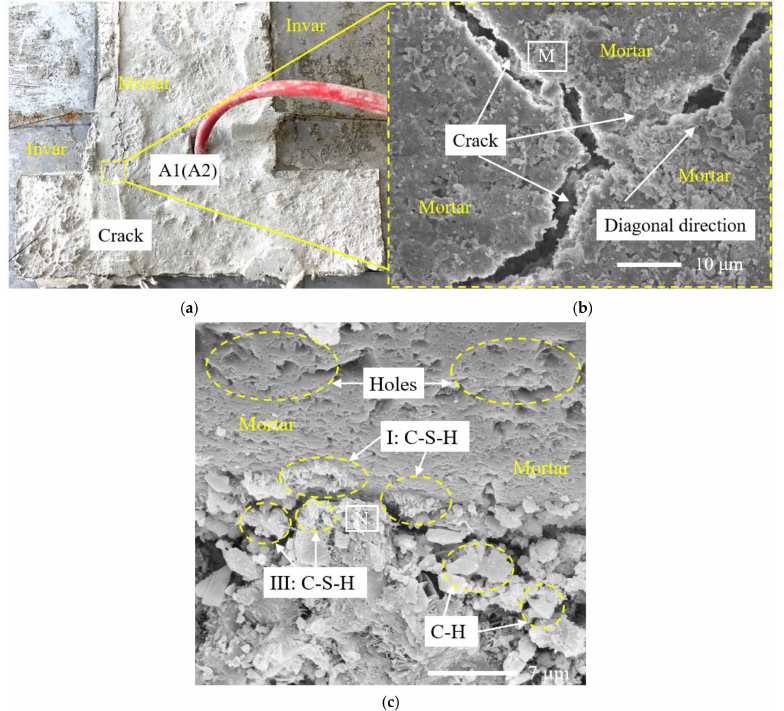
Figure 8. Microstructure and position of specimen 1. ( a ) Position of samples A1 and A2; ( b ) the microstructure of sample A1 and the position of region M; ( c ) the microstructure of sample A2 and the position of region N.